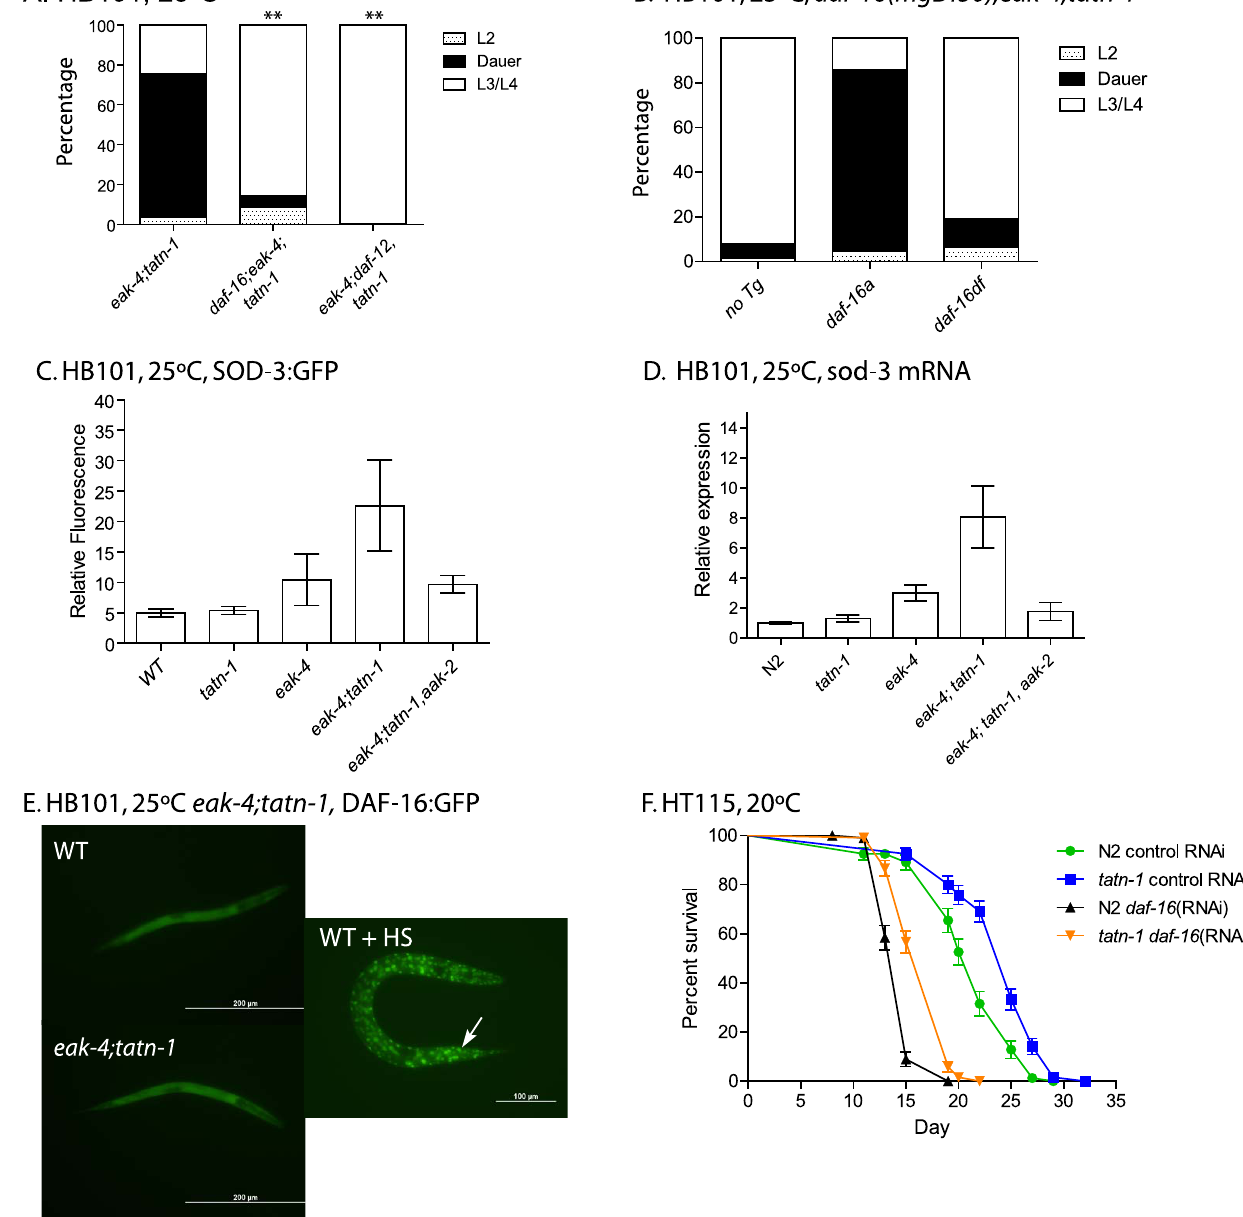
Figure 6. tatn-1 acts by daf-16 /FOXO dependent and independent mechanisms. (A) Mutations in daf-16 ( daf-16(mgDf47) ) or daf-12 ( daf- 12(rh61rh411) ) inhibit dauer formation by eak-4(mg348); tatn-1(baf1) mutant worms. ** p , 0.001 by Fisher’s exact test. (B) The daf-16(mgDf50) mutation also inhibits dauer formation by eak-4; tatn-1(baf1) mutants, and a transgene expressing the DAF-16A isoform largely rescues dauer formation by daf-16(mgDf50); eak-4; tatn-1 mutants while a transgene expressing the DAF-16DF isoform only weakly rescues. (C) eak-4; tatn-1 mutants activate expression of the daf-16 target gene sod-3 as indicated by expression of a sod-3p:GFP reporter gene in L2 larvae, and this induction requires the aak-2 /AMPK gene. * p , 0.05 for t-test comparisons of eak-4 vs. eak-4; tatn-1 , and eak-4; tatn-1 vs. eak-4; tatn-1; aak-2 . (D) Induction of the endogenous sod-3 gene in eak-4 ; tatn-1 mutants is seen by quantitative RT-PCR, and this induction also depends on the aak-2 /AMPK gene. (E) DAF- 16A:GFP is not nuclear localized in either L2 stage WT or eak-4; tatn-1 larvae, but exposure to a 1 hour 35 u C heat shock produces clear nuclear localization of DAF-16A:GFP (arrow). (F) tatn-1 effects on lifespan are daf-16 independent. Treatment of N2 and tatn-1(baf1) mutants with daf-16 RNAi reduces mean survival, but tatn-1(baf1) still lives longer than N2. The mean survival of N2 control RNAi, tatn-1 control RNAi, N2 daf-16(RNAi) , tatn-1 daf-16(RNAi) are 21.0, 24.0, 14.5, and 17.0 days. p , 0.001 for comparison of N2 control RNAi vs. tatn-1 control RNAi, and tatn-1 daf-16 (RNAi) vs. tatn-1 control RNAi by log-rank test. doi:10.1371/journal.pgen.1004020.g006 tatn-1(baf1) daf-16(RNAi) 17.0 days). Specifically, tatn-1(baf1) worms. These data suggest that the increased lifespan resulting produced a 13.7% increase in lifespan in control RNAi treated from tatn-1 is either independent of daf-16 or occurs in a site worms, but a 17.8% increase in lifespan in daf -16 RNAi treated resistant to the effects of daf-16 RNAi.